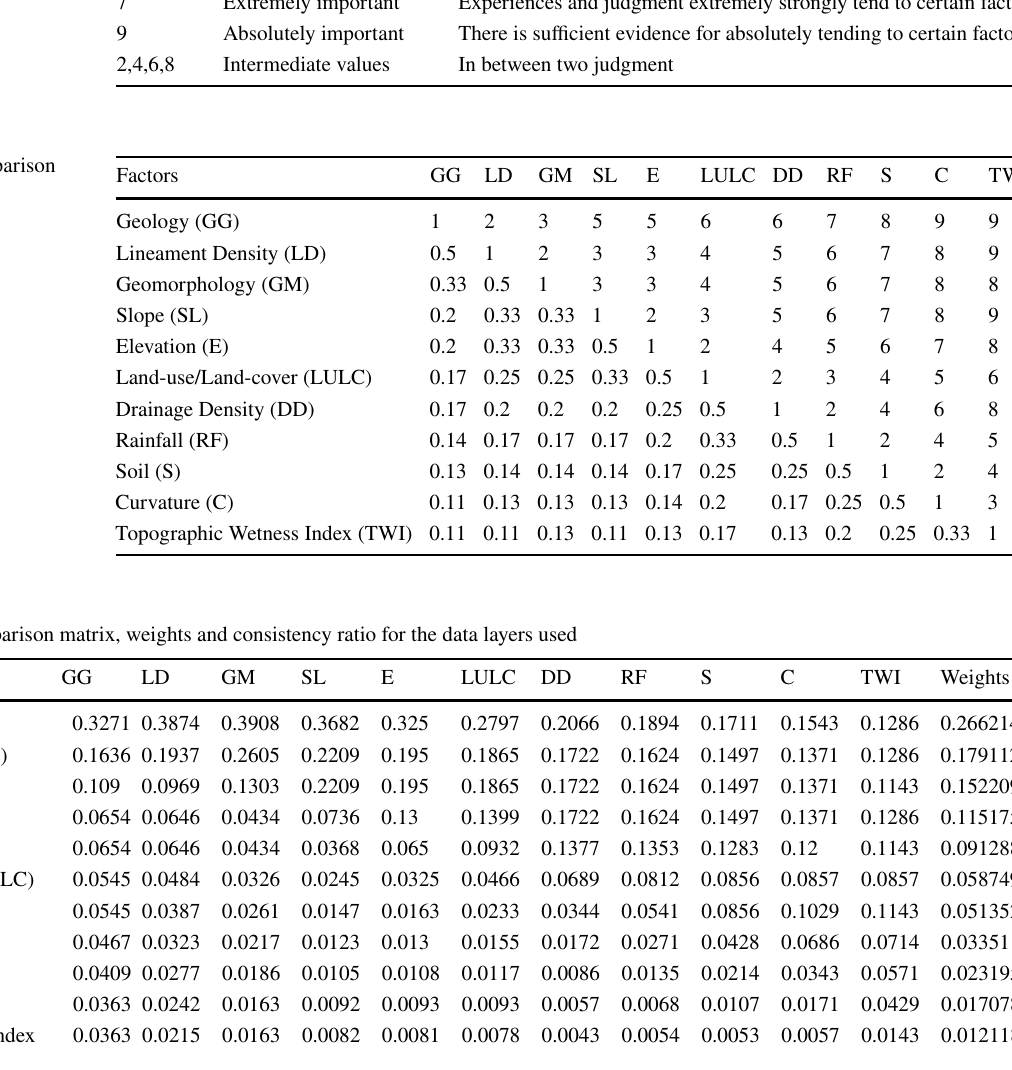
Table 2 Description of scales for pair comparison with AHP ( Source: Satty, 1990)